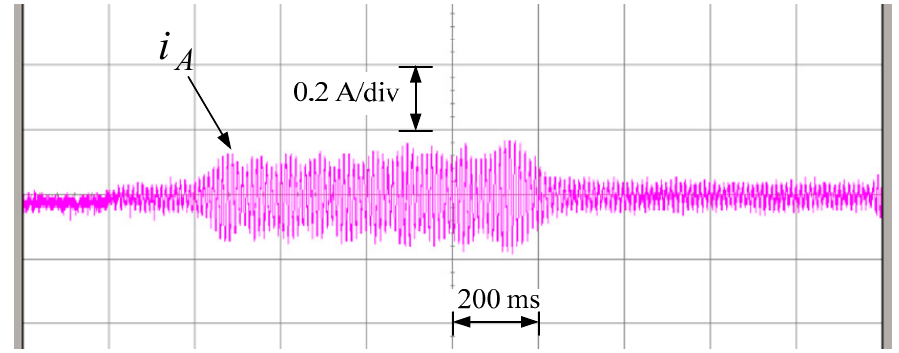
Figure 23. The position and speed responses with load.